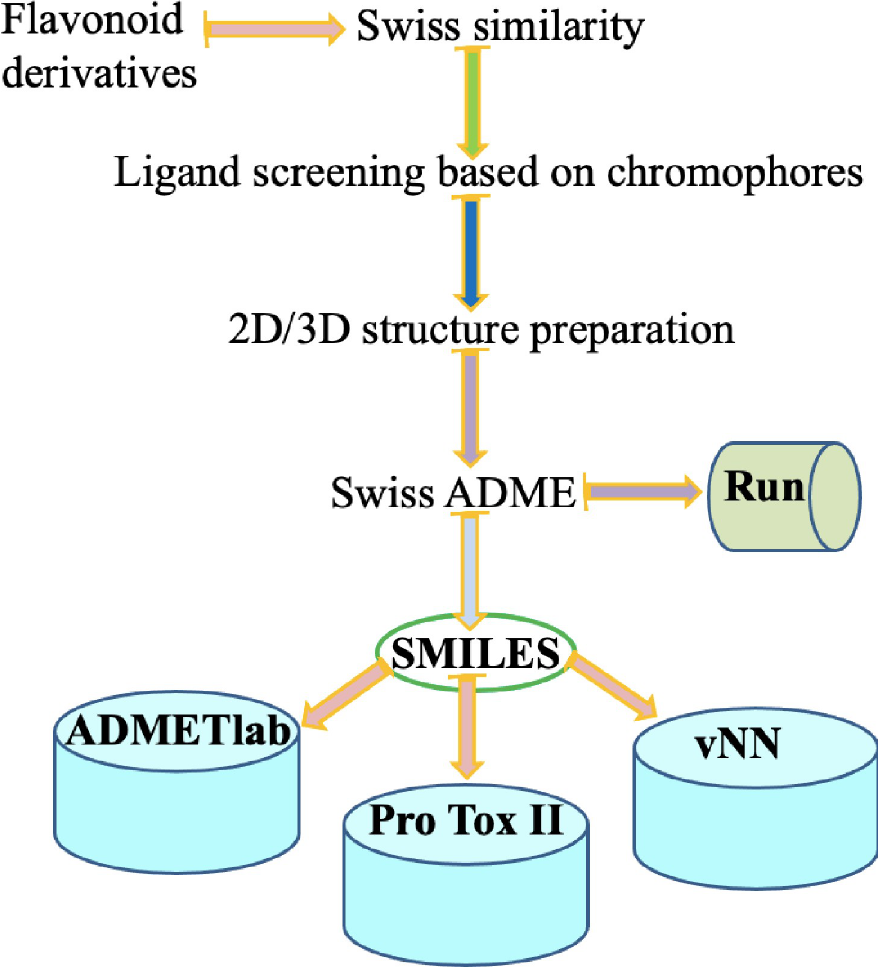
Fig 1. Schematic representation of ligand screening flowchart. vNN stands for variable nearest neighbor.